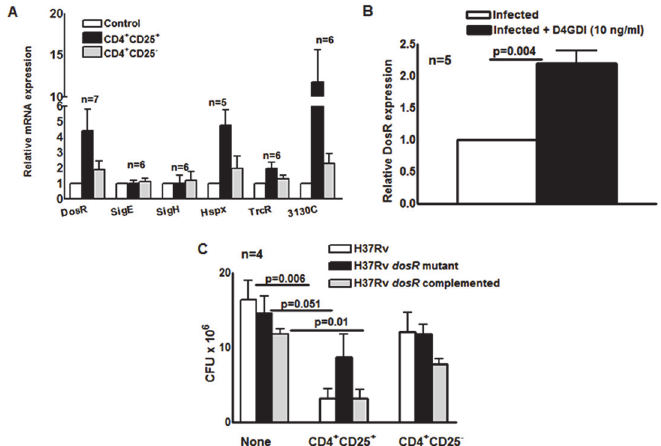
Figure 9. Effect of CD4 + CD25 + Foxp3 + cells and D4GDI on M. tb expression of dosR . (A) MDMs from